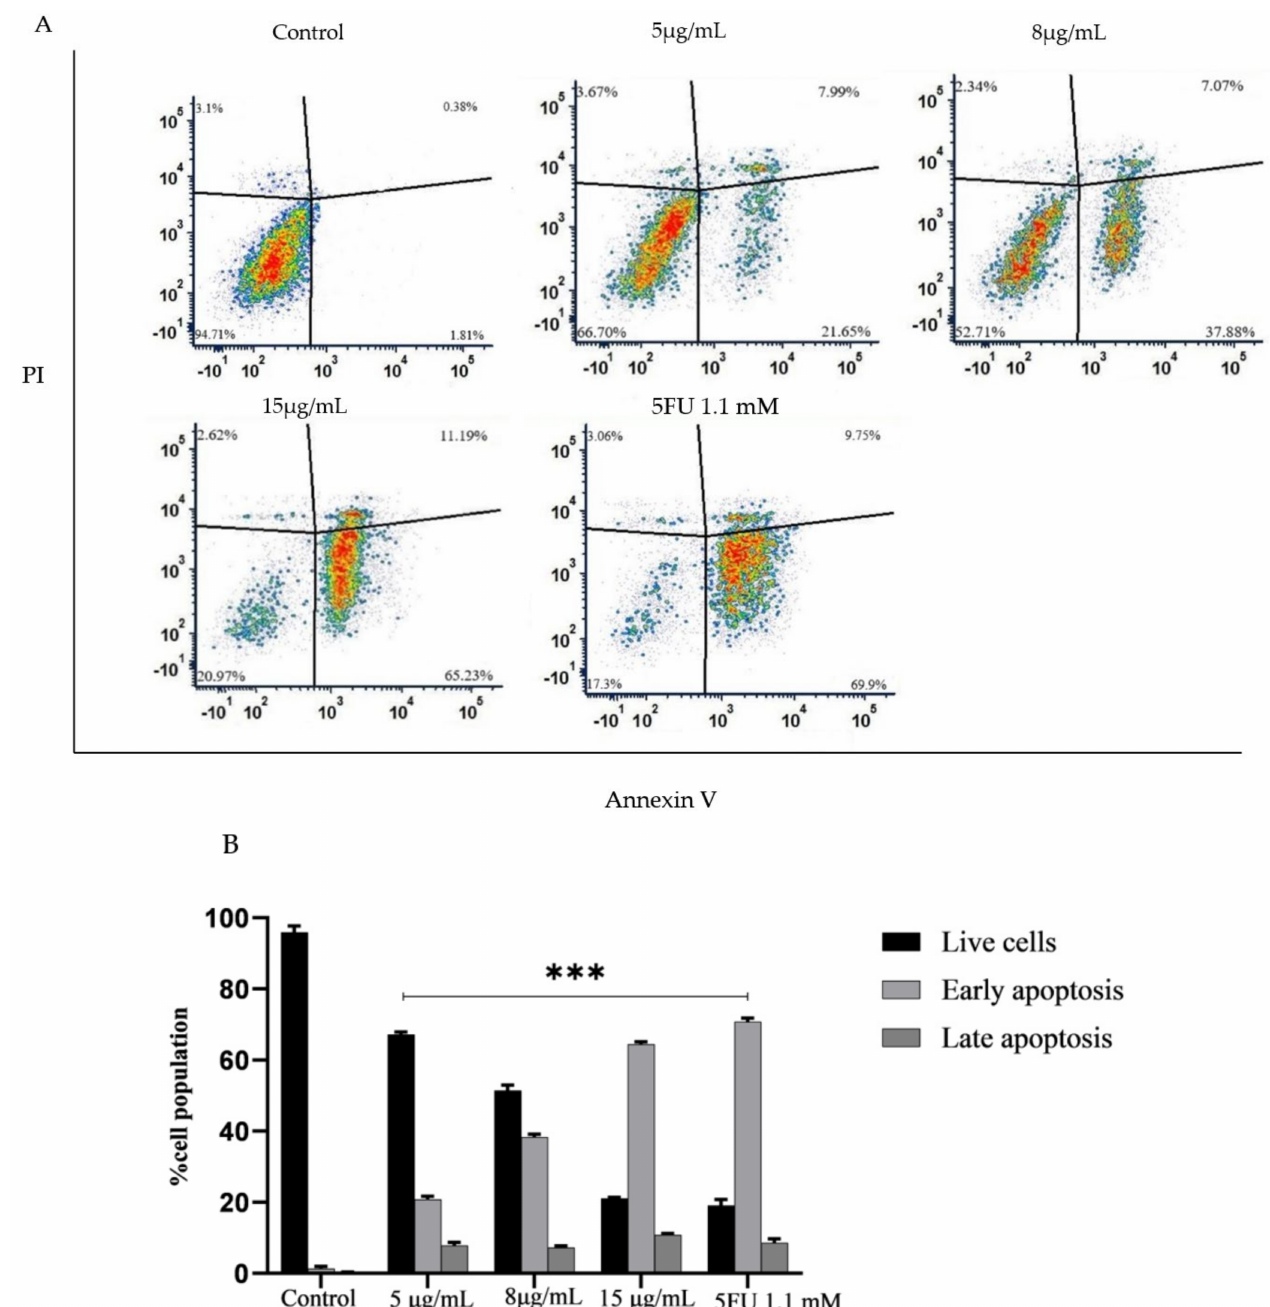
Figure 6. HCT-116 cells were treated with PPE (515 µ g/mL) and 5FU (1.1mM) for 24 h, and a percentage of apoptosis was detected by staining with Annexin/PI. ( A ) Scatter plot of Annexin V and PI on X and Y axis, respectively, ( B ) Graphical representation of the live cells, early apoptotic and late apoptotic cells.The values indicate ± SD ( n = 3); *** p < 0.001 vs.